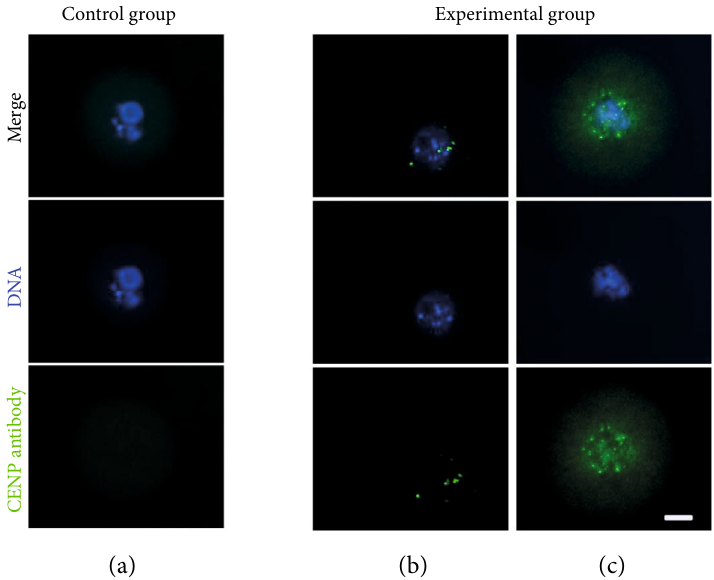
Figure 2: Cellular existence of the CENP-C antibody in mouse oocytes. Mouse oocytes from the control group and experimental group were immunolabeled with FITC-conjugated goat anti-mouse IgG for the CENP-C antibody (green) and counterstained with DAPI for chromosomes (blue). We detected whether the anti-CENP-C antibody was in oocytes at the GV stage and at the GVBD stage to ensure the antibody ’ s entrance into the cell before metaphase. The CENP-C antibody found in GV oocytes (b) and GVBD oocytes (c) from the experimental group. The CENP-C antibody was not detected in GV oocytes from the control group. Images were captured using a 20x objective lens and 10x eyepiece. Scale bar: 20 μ